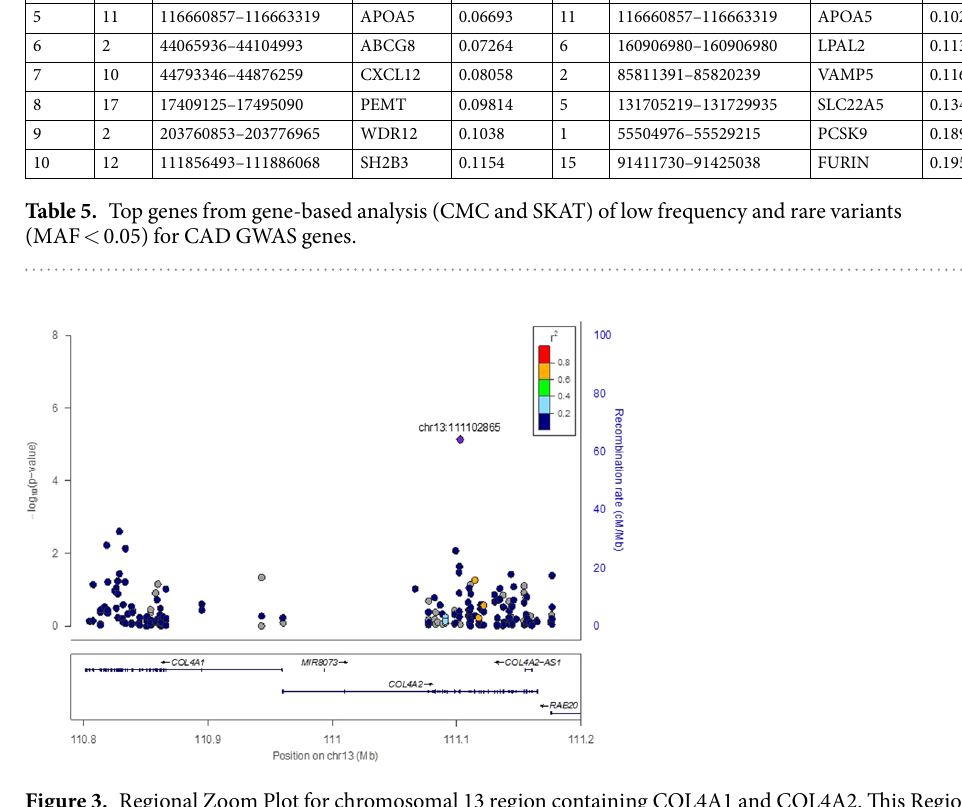
Figure 3. Regional Zoom Plot for chromosomal 13 region containing COL4A1 and COL4A2. This Regional Zoom Plot shows the positions (X-axis) and − log 10 (p) values (Y-axis) for variants in COL4A1 and COL4A2 (maps below plot), LD among variants (colors of dots), and recombination rates (blue curve) for this region of chromosome 13.